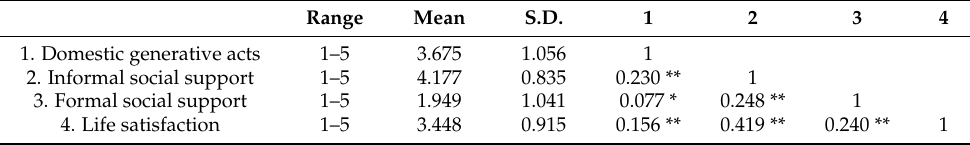
Table 2. Descriptive statistics and bivariate correlations for key variables (N =